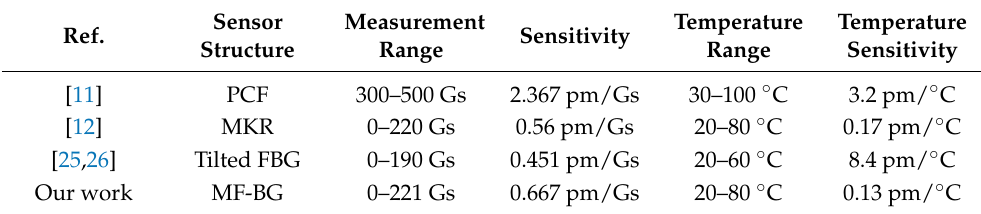
Table 1. Performance of FF-based fiber sensors compared with other works.